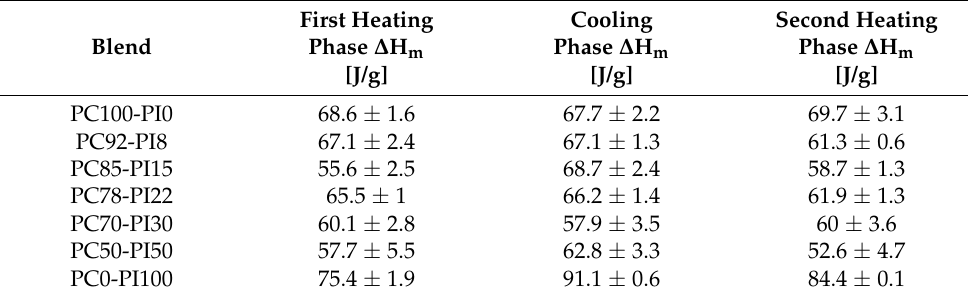
Figure 6. Thermograms of all blends during the second heating phase. Table 4. Enthalpy of fusion for each blend measured in the heating and cooling